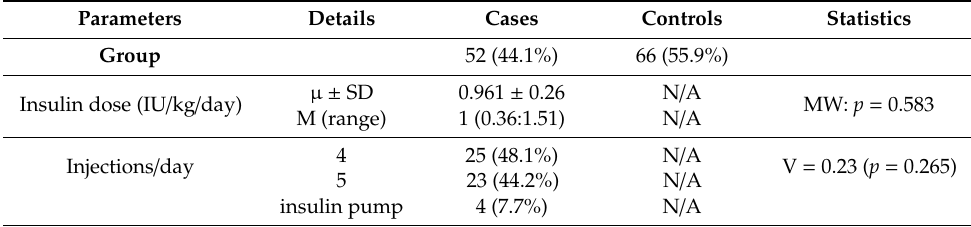
Table 5. Insulin therapy in Type 1 diabetes mellitus (T1DM)